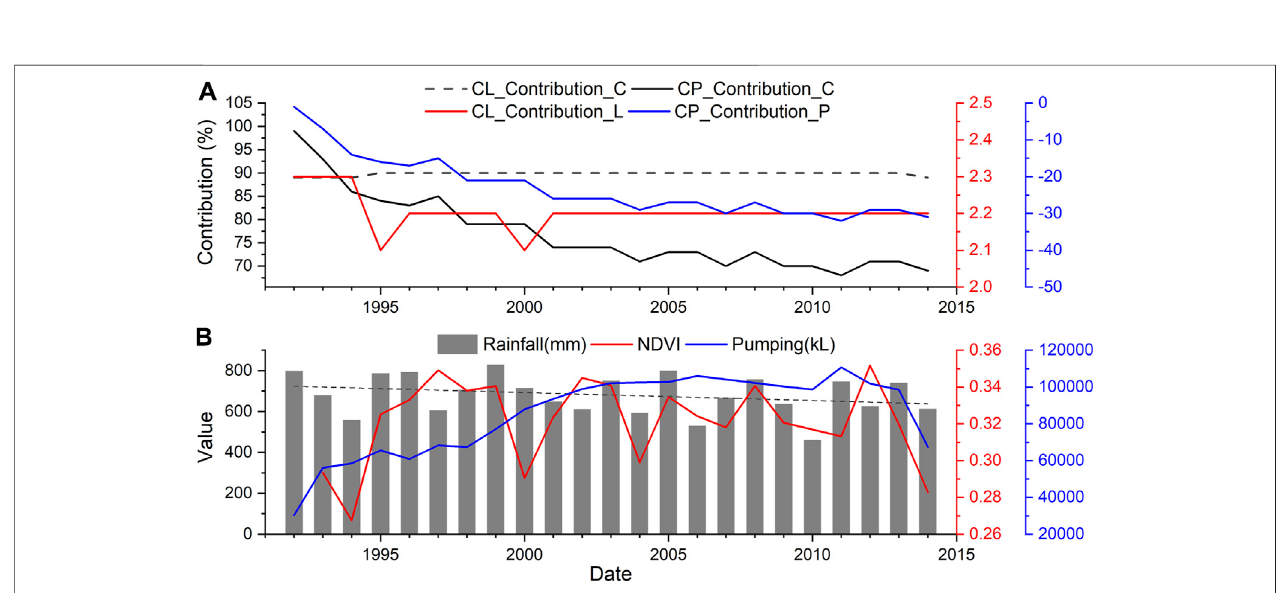
FIGURE11 | Contribution rates inthe climate-only (C), climate and land cover (C + L),and climate and pumping(C + P) analyses tothe groundwater level changes (A) . Rainfall, NDVI and groundwater pumping in the Gnangara region (B) .